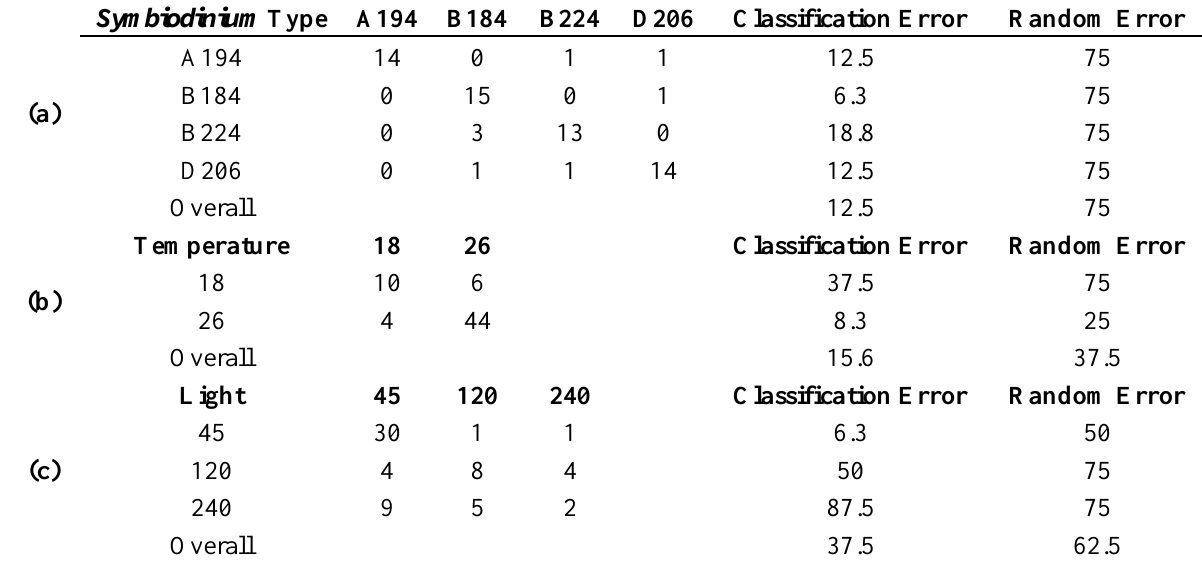
Table 1. Confusion matrices from Random Forests classification of experimental factors ( a ) Symbiodinium type; ( b ) temperature (°C), and ( c ) light levels (μmol photons m −20 s −1 ). Rows are a priori designated levels and columns are predicted levels. Classification Error is the percent of misclassified samples in each category, and the final row, “Overall”, is the total percent of samples misclassified. Random Error is the classification error expected by random assignment based on the distribution of sample sizes among